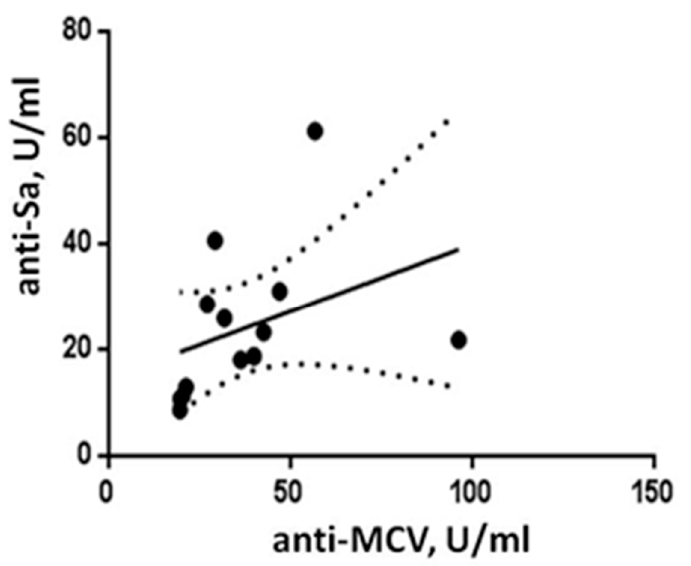
Figure 1. Correlation analysis of antibodies to mutated citrullinated vimentin (anti-MCV) and anti-citrullinated vimentin (anti-Sa) in patients with sarcoidosis. Significant difference was found when comparing the anti-MCV antibody concentra- tions in patients with sarcoidosis and non-infectious lung disease ( p = 0.0003). A significant